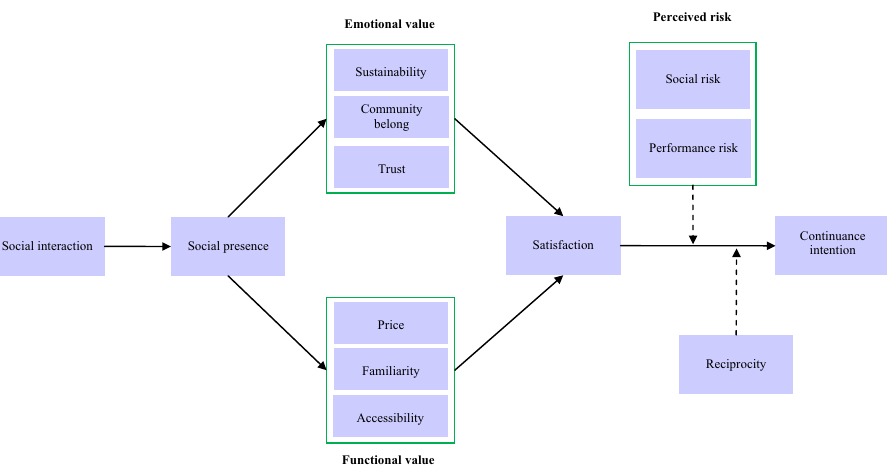
Fig. 1 The proposed conceptual model shows the study ’ s conceptual model. The model examines the relationship between social presence, three emotional and three functional factors, satisfaction and continuance intention. The moderators are perceived risk